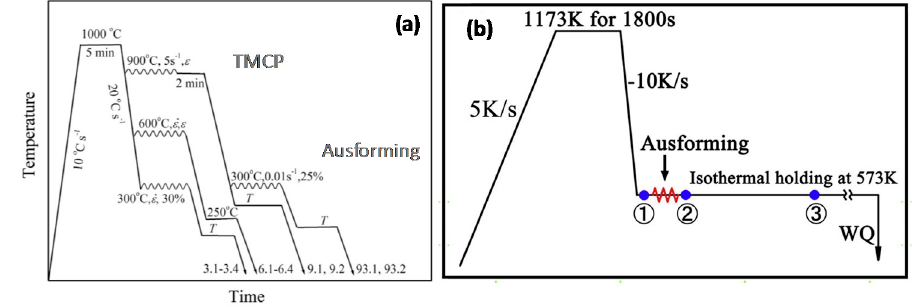
Figure 7 . Examples of thermomechanical treatment applied to austenite prior to bainitic transformation. Extracted from references [47,48]. Reproduced with permission from Elsevier, 2017.